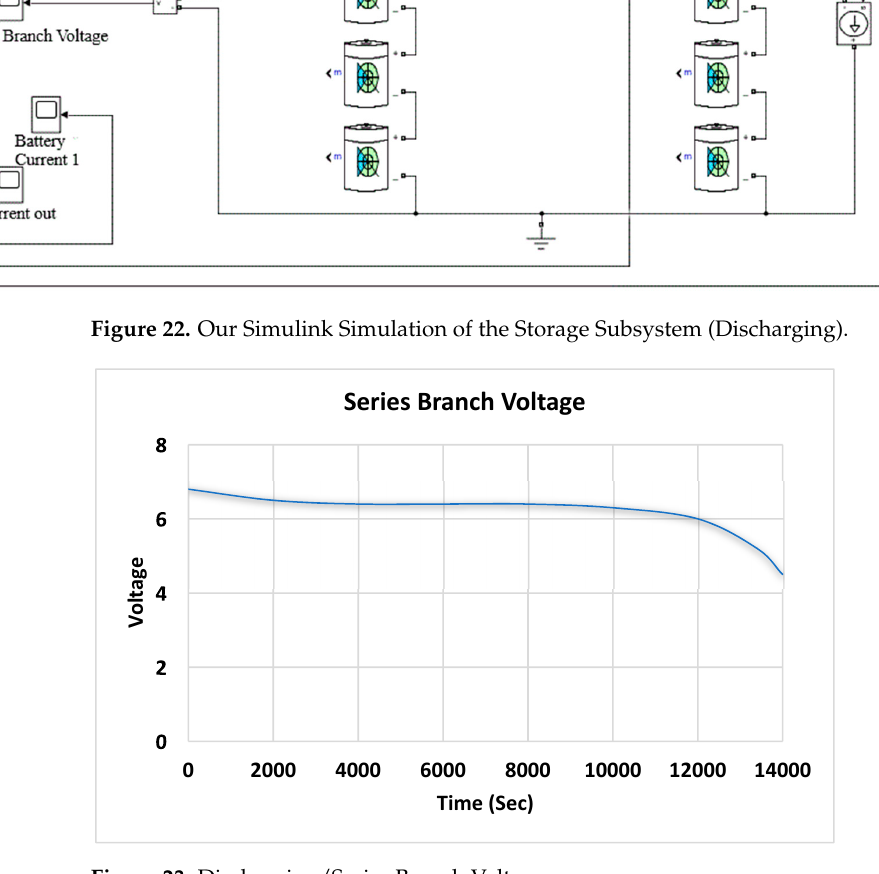
Figure 23. Discharging/Series Branch Voltage.